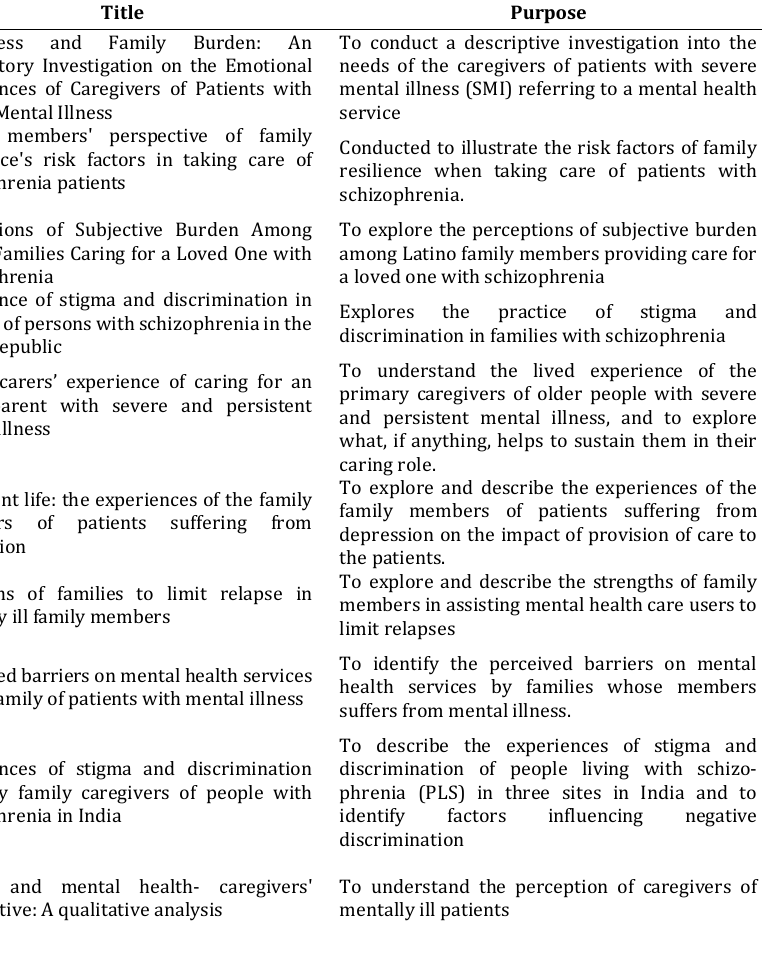
Table 2. Study characteristics (Country, title &